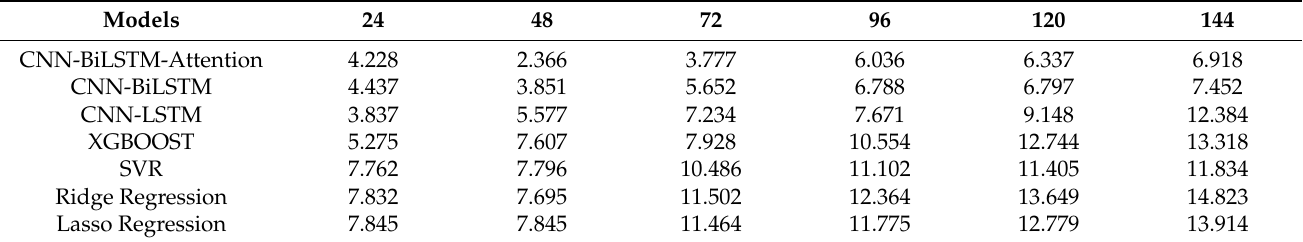
Figure 12. Long-term prediction of PM2.5 concentration by CNN-BiLSTM-Attention model. Table 6. MAE for long-term prediction of each model (Unit: µ g/m 3 ).